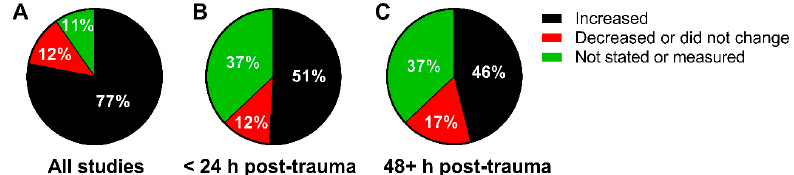
Figure 2. ( A ) Percent of studies that measured an increase, decrease or no change, or did not state or measure changes in pterins. ( B ) Studies that reported a change in pterin concentration within 24 hours of trauma or ( C ) greater than 48 hours post-trauma. Table 1. Studies measuring pterins following impact-induced trauma in exercise and sport.